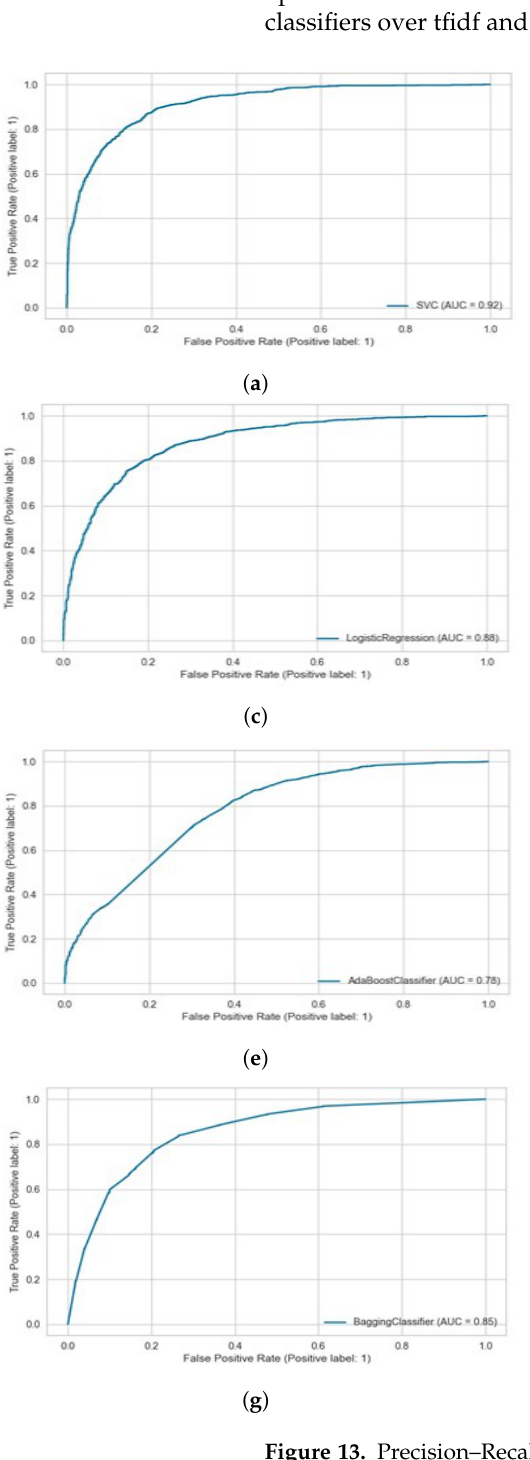
Figure 13. Precision–Recall curves for the proposed algorithms at highest accuracy level in each case. ( a ) SVM (Tfidf + unigrams). ( b ) Naïve Bayes (Tfidf + unigrams). ( c ) Logistic regression (Tfidf + unigrams). ( d ) Decision tree (unigrams + trigrams). ( e ) AdaBoost (unigrams + trigrams). ( f ) Xboost (Tfidf + unigrams). ( g ) Bagging classifier (Tfidf + uni). Bag-of-words (BOW) features were extracted from Roman Urdu data using Count Vectorizer. The results for mean accuracy, precision, recall, and F1-score, including standard deviation, specifically over the cyberbullying class are highlighted in Table 7. Most